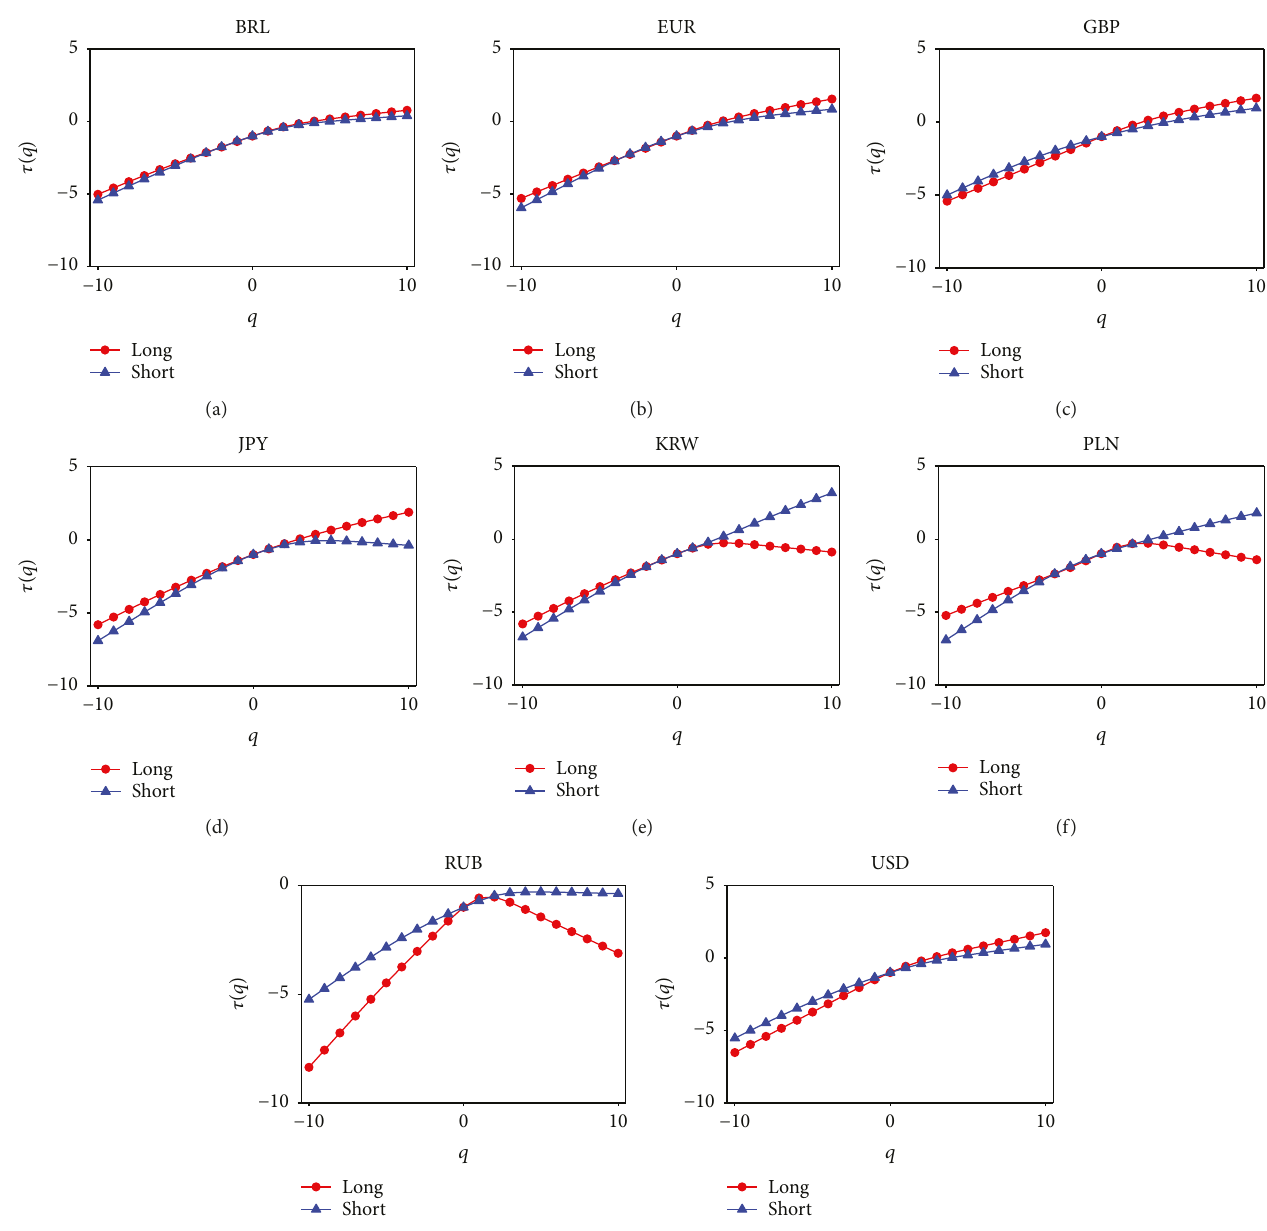
Figure 10: The long-term and short-term mass exponent values of τ